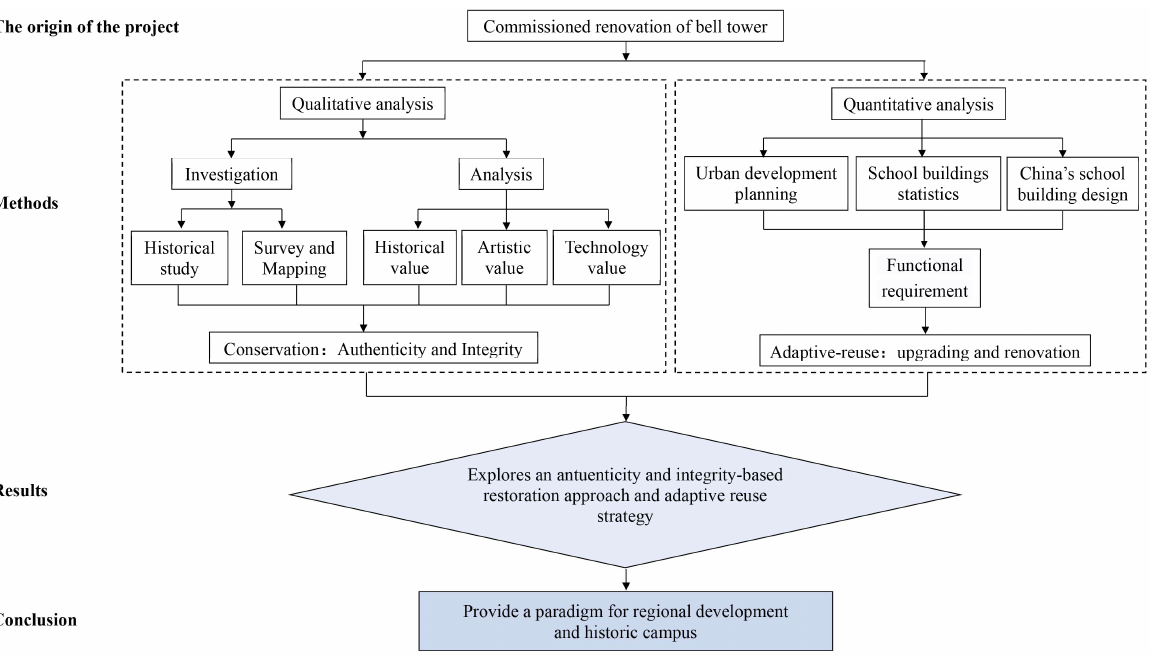
Figure 4. Research Framework (source: author).